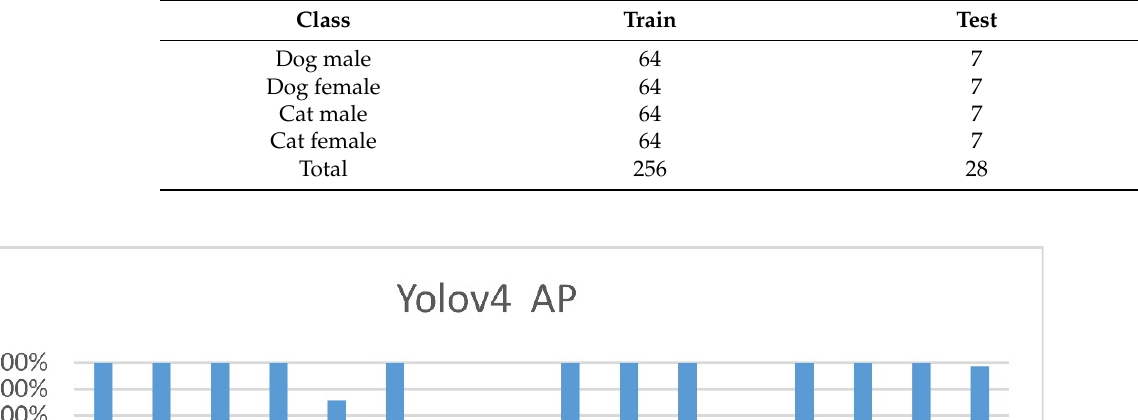
Table 16. Training and test samples for four classes of TNR under the balanced dataset.